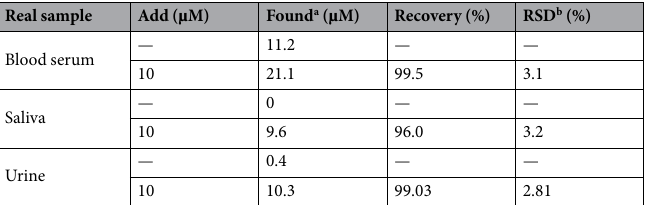
Table 2. The recoveries for the determination of glucose in human saliva, urine and blood serum. a Standard deviation method and b Relative standard deviation with three repetitive